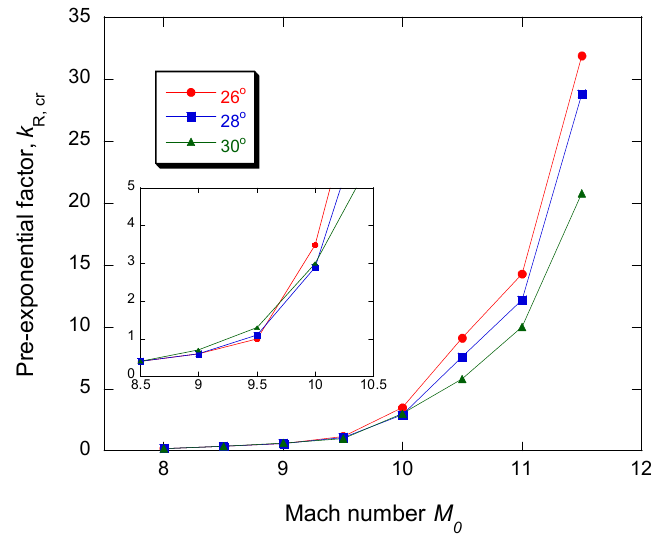
Figure 12. The conditions for smooth and abrupt transitions below and above the boundary respectively in the k R,cr – M 0 plane for three different wedge angles θ .